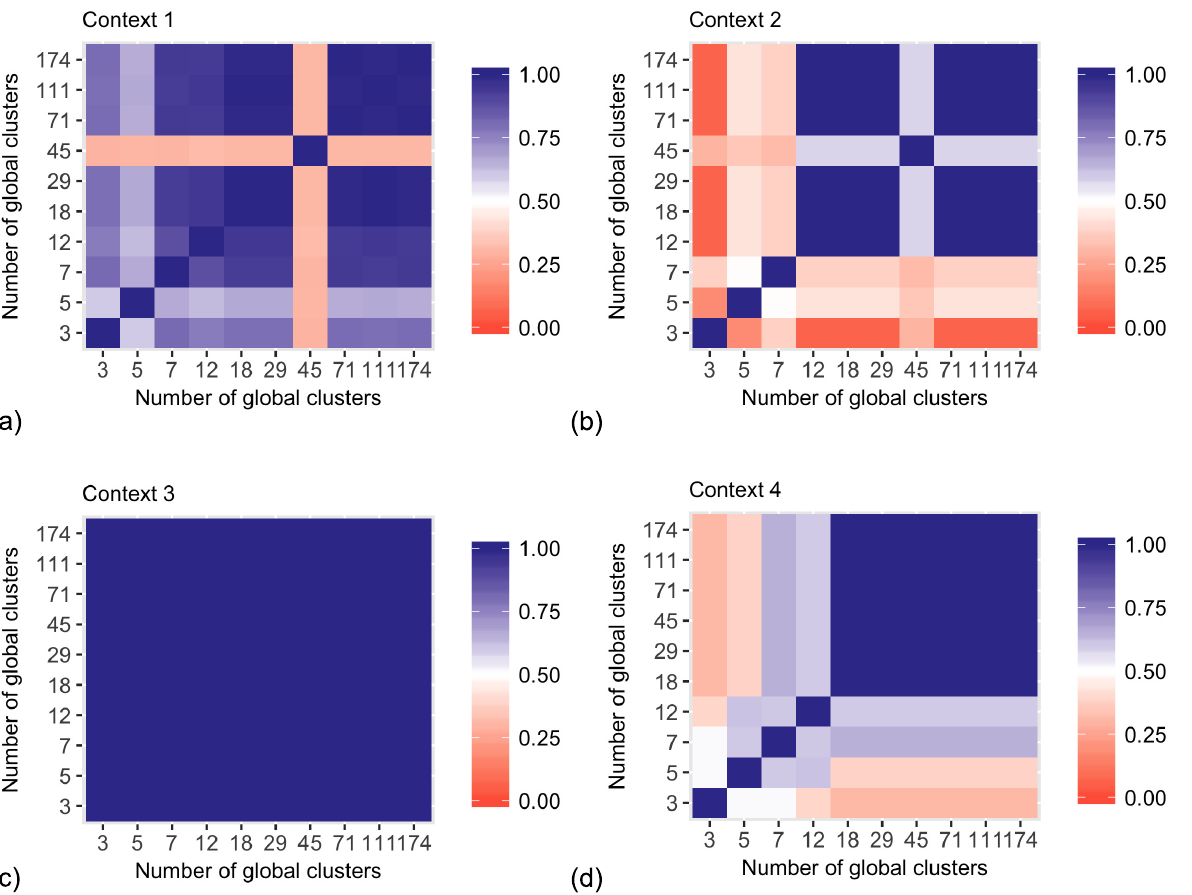
Fig 14. Consistency between local clustering results for different number of global clusters with 3 context-specific clusters, as measuredby the ARI. The ARI values show severallocal optima. (a) Gene expressioncontext. (b) DNA methylationcontext. (c) miRNA context. (d) RPPA